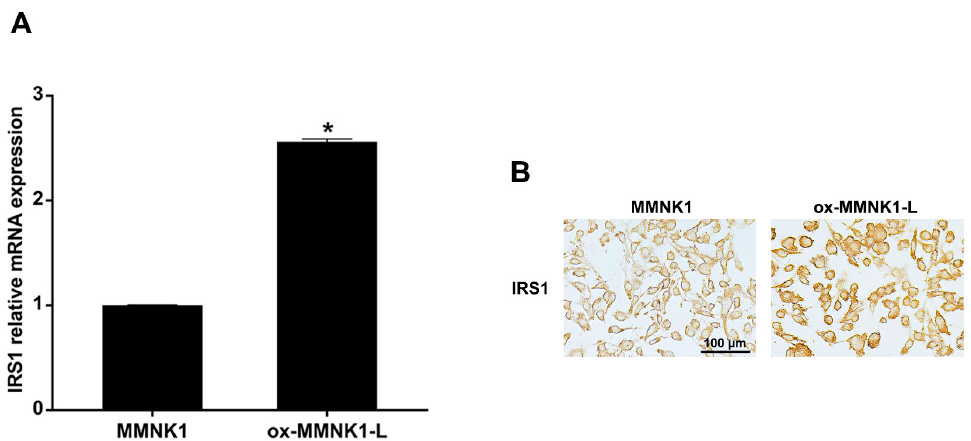
Figure 3. Expression of IRS1 in an oxidative-stress-resistant cholangiocyte cell line (ox-MMNK1-L). ( A ) Relative IRS1 mRNA expression levels in MMNK1 and ox-MMNK1-L cells assessed by real- time PCR. * p -value < 0.05 compared with MMNK1. ( B ) Immunocytochemical staining of IRS1 in ox-MMNK1-L and MMNK1 cells.